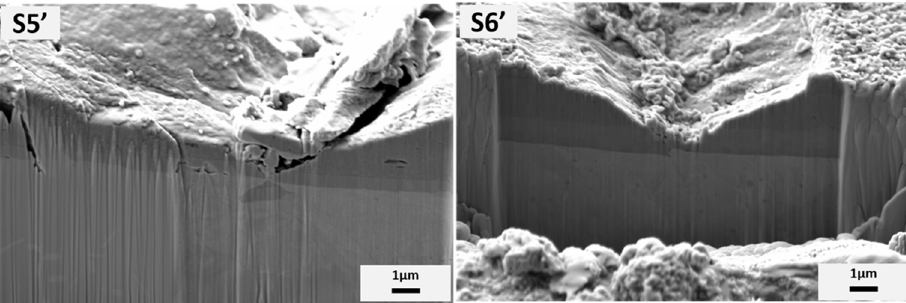
Figure 13 . Cross-sectional SEM images with two magnifications of partial ring cracks at 613 N with a Rockwell C tip after 800 °C treatment marked in Figure 12 .